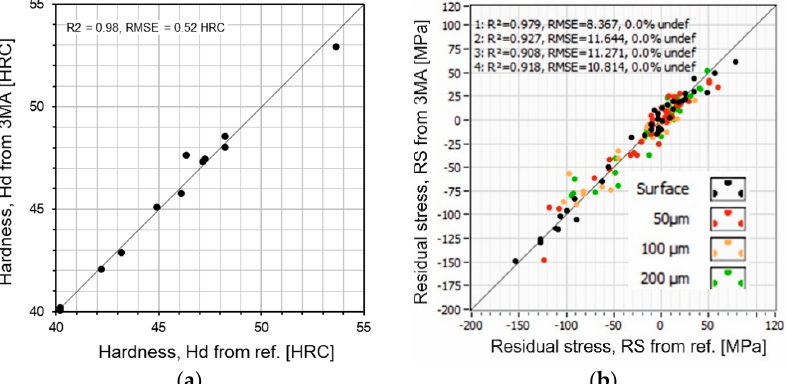
Figure 12. Results of the calibration to: ( a ) hardness and ( b ) residual stress at the surface and at depths of 50, 100 and 200 μ m (all RMSE values in MPa).